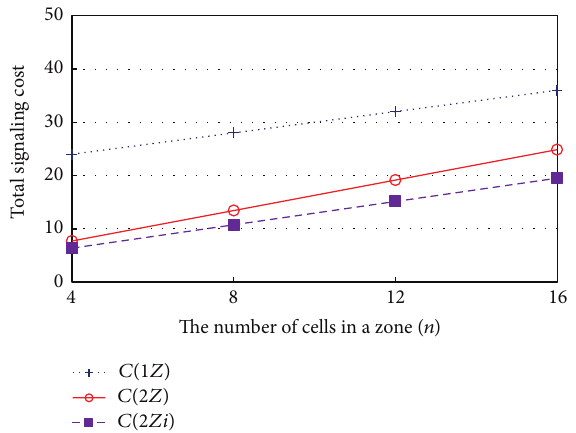
Figure 6: Signaling cost with respect to the number of cells in a zone ( 𝜆 𝑜𝑐 = 𝜆 𝑚 = 5